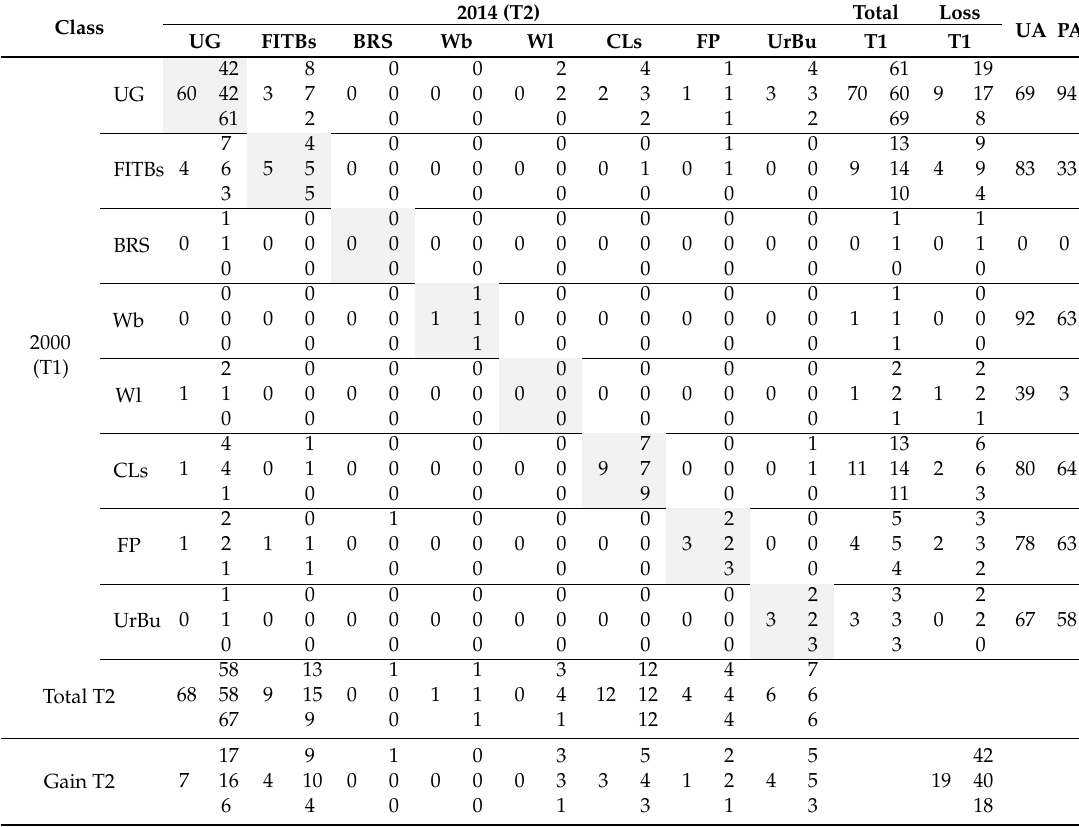
Table 8. Transition matrix for the 2000 (T1)–2014 (T2) change. The left entries in the cells represent matrix D, the upper right entries matrix U, the middle right entries matrix M and the lower right entries matrix L. All entries express the percent of the study area. Persistence of LC classes is highlighted in grey on the diagonal, with change on the